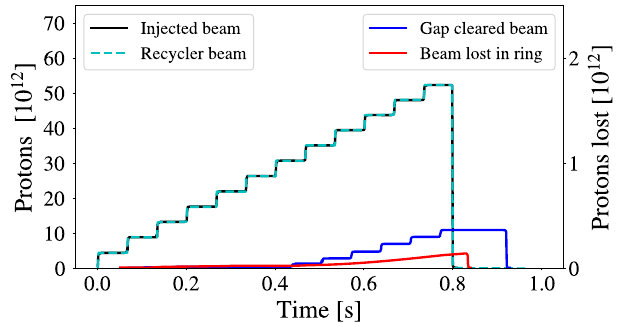
FIG. 12. The beam injected (left scale) into the Recycler during a “ 6 þ 6 ” cycle along with the gap cleared beam and beam lost (right scale) in the ring in 2018.